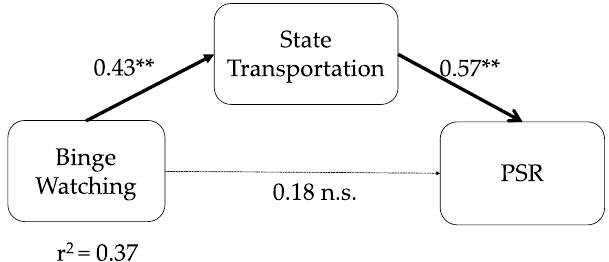
Figure 2. Model of the effect of condition on PSR, mediated by transportation. ** p < 0.01.